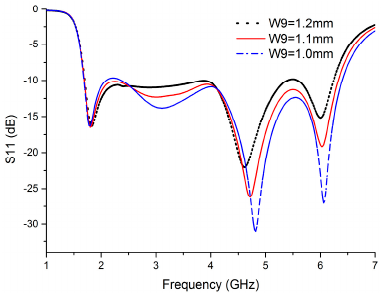
Figure 8. Reflection coefficient (S11) of the BRA versus frequency with the variation of W9.